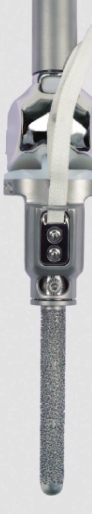
Figure 1: MML tumor knee for proximal tibial and distal femoral replacement (Modular endoprosthetic system Munich-Luebeck, Eska Orthodynamics GmbH, Luebeck, Germany) with the tibial fixation device for the double-layered Trevira